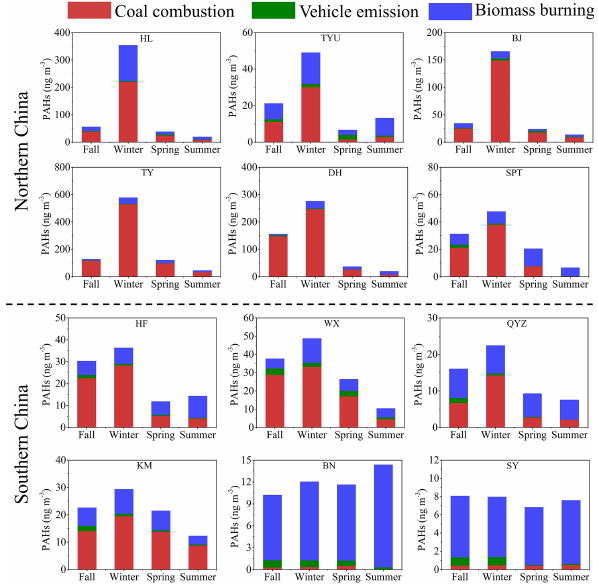
Figure 9. Seasonal variations of PAHs’ source contributions in